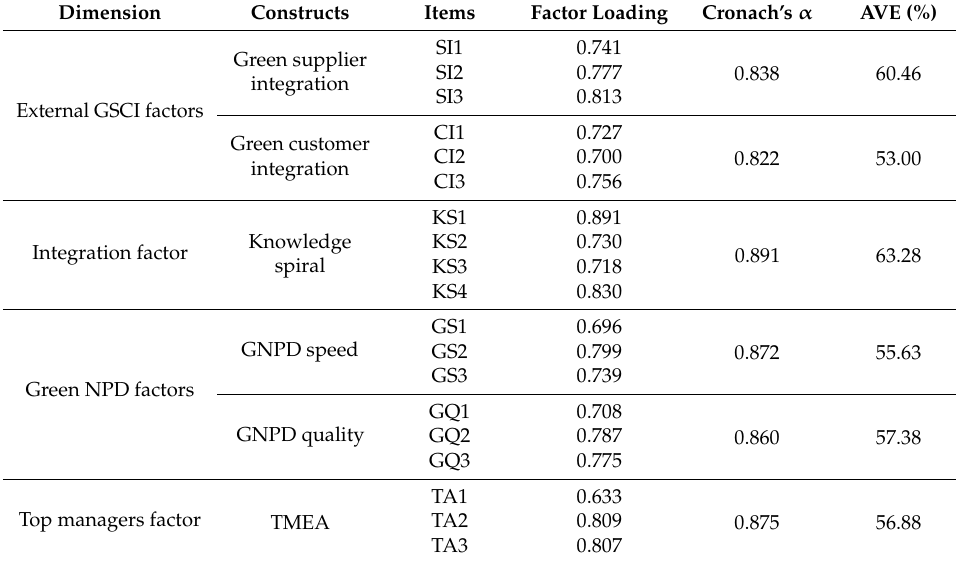
Table 2. Reliability analysis for each scale.